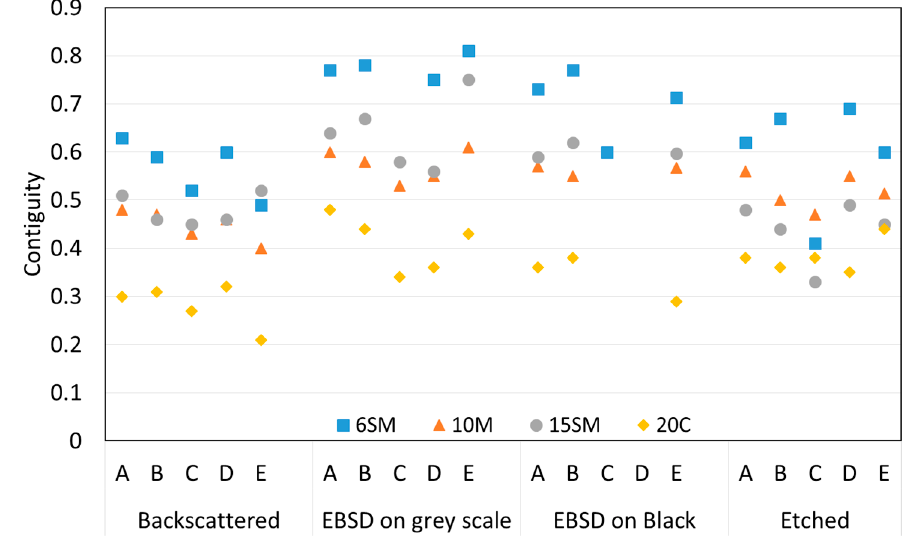
Figure 4. Graph of all the measurement results shown in Table 2 to emphasise the difference in contiguity between hardmetal grades (colour) and between image type (blocks of values changing along the X -axis).